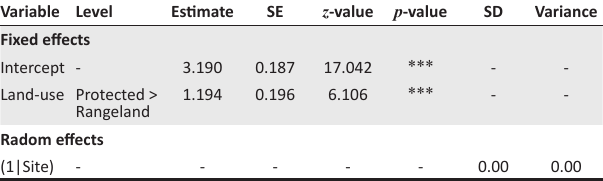
TABLE 4-A1: Results from generalised linear mixed effects models comparing median avian body mass between land-use types (protected areas versus communal rangelands), while taking vegetation structure variables (maximum grass leaf table height and the density of woody vegetation greater than 0.5 meters) into consideration.